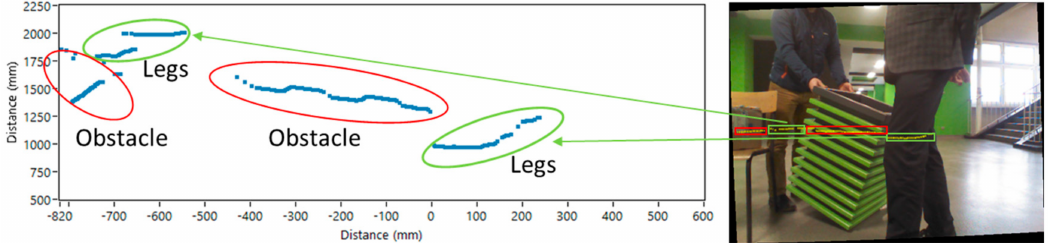
Figure 11. Raw measurements and corresponding image of a complex